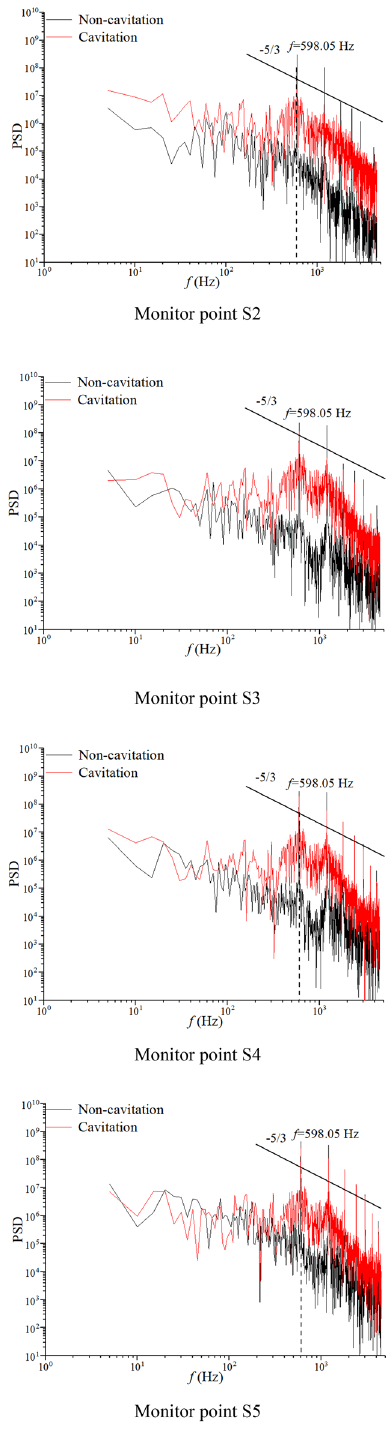
Figure 16 Power spectrum of pressure